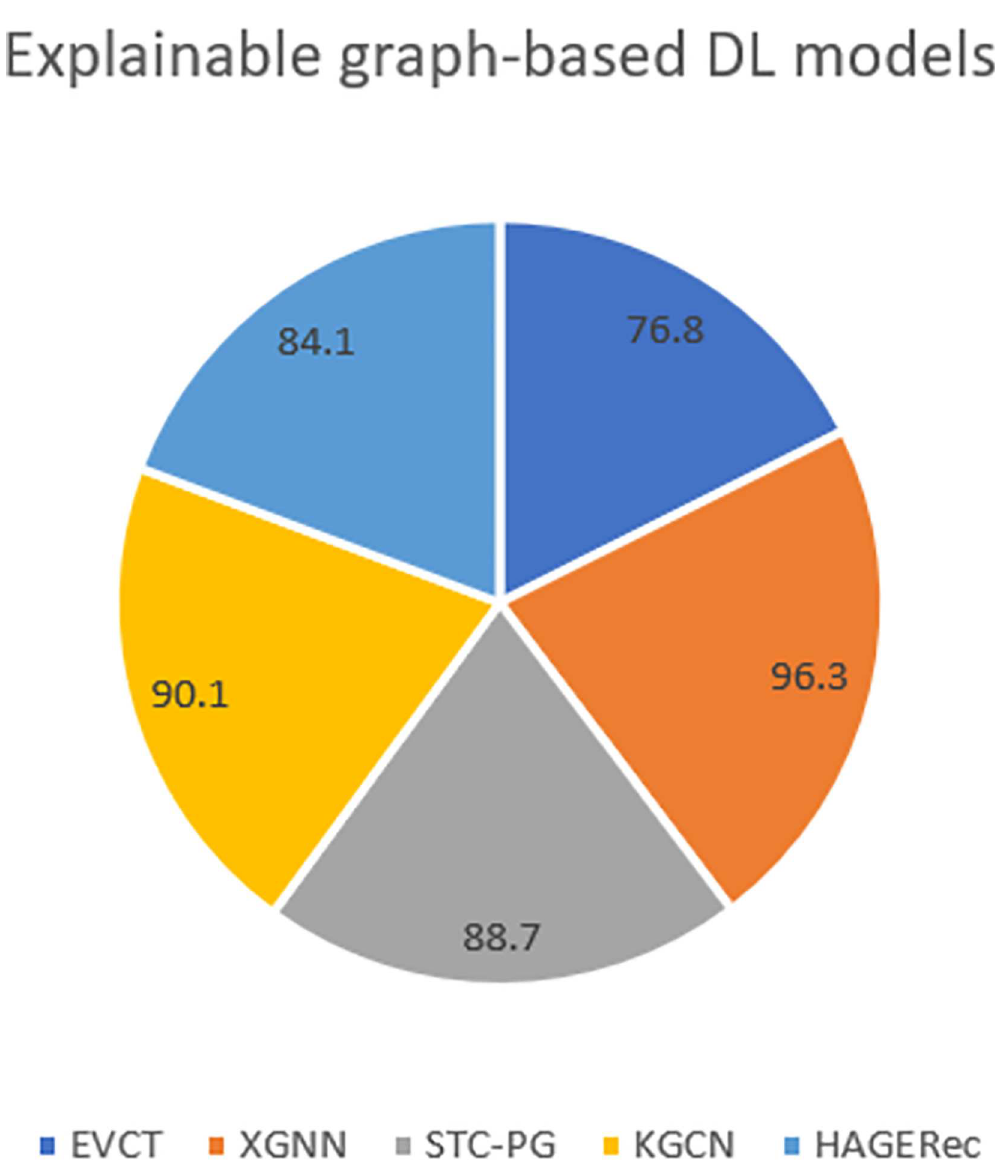
Fig 10. Overall comparison of predictive accuracy. EVCT [72]: Explainable and Visualizing CNN for text information. XGNN [73]: Explainable Graph Neural Network. STC-PG [75]: Spatial Temporal and Causal -Parse Graph. KGCN [76]: Graph-based Convolutional Network for chemical structure. HAGERec [77]: Hierarchical Attention Graph Convolutional Network Incorporating Knowledge Graph for Explainable Recommendation.